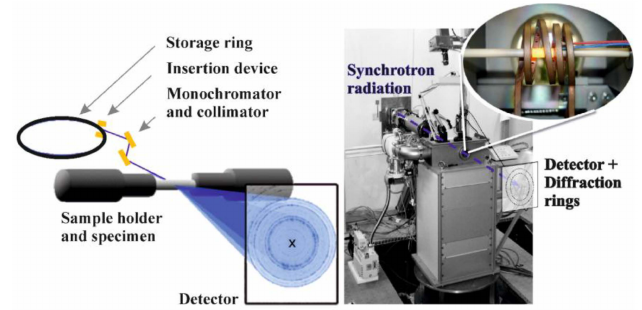
Figure 4. Typical experimental setup for HEXRD. The scheme to the left illustrates the pathway of high-energy X-rays (blue) from their generation at an insertion device in the storage ring, up to their diffraction from the specimen in the sample holder. An area detector at the front captures sets of Debye-Scherrer rings [52]. The photograph on the right shows the quenching and deformation dilatometer [64,66] as an example of a versatile sample environment installed at the PETRA III High Energy Materials Science (HEMS) beamline. In the insert at the top, a heated specimen is glowing during an in situ experiment. (Reproduced with permissions from Reference [52]. Copyright